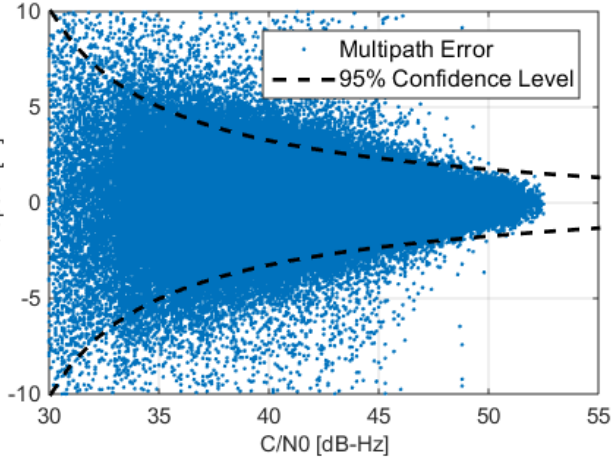
Figure 8. Variation of the multipath and observation noise with the C/N0. The dashed line shows that the weighting model agrees well with the multipath and observation noise.